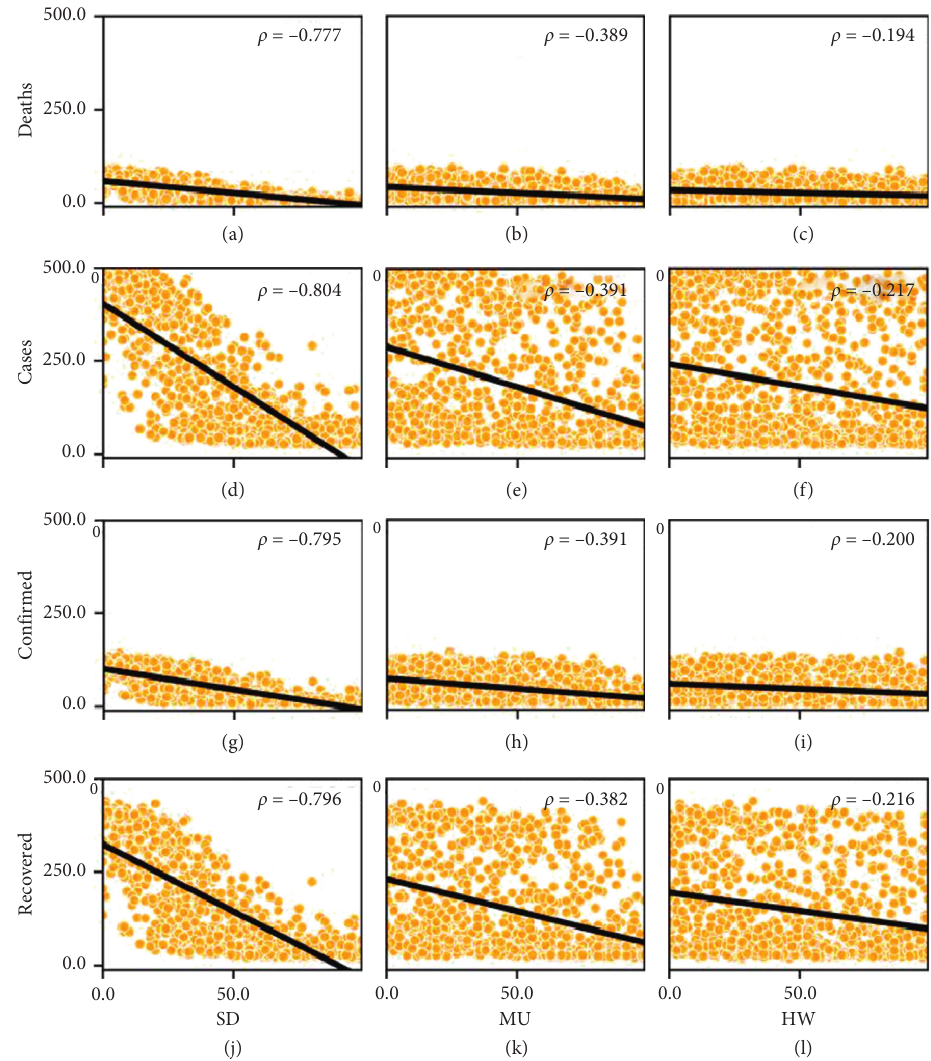
Figure 9: Correlation analysis between outcome variables and input parameters, reported with p < 0 .